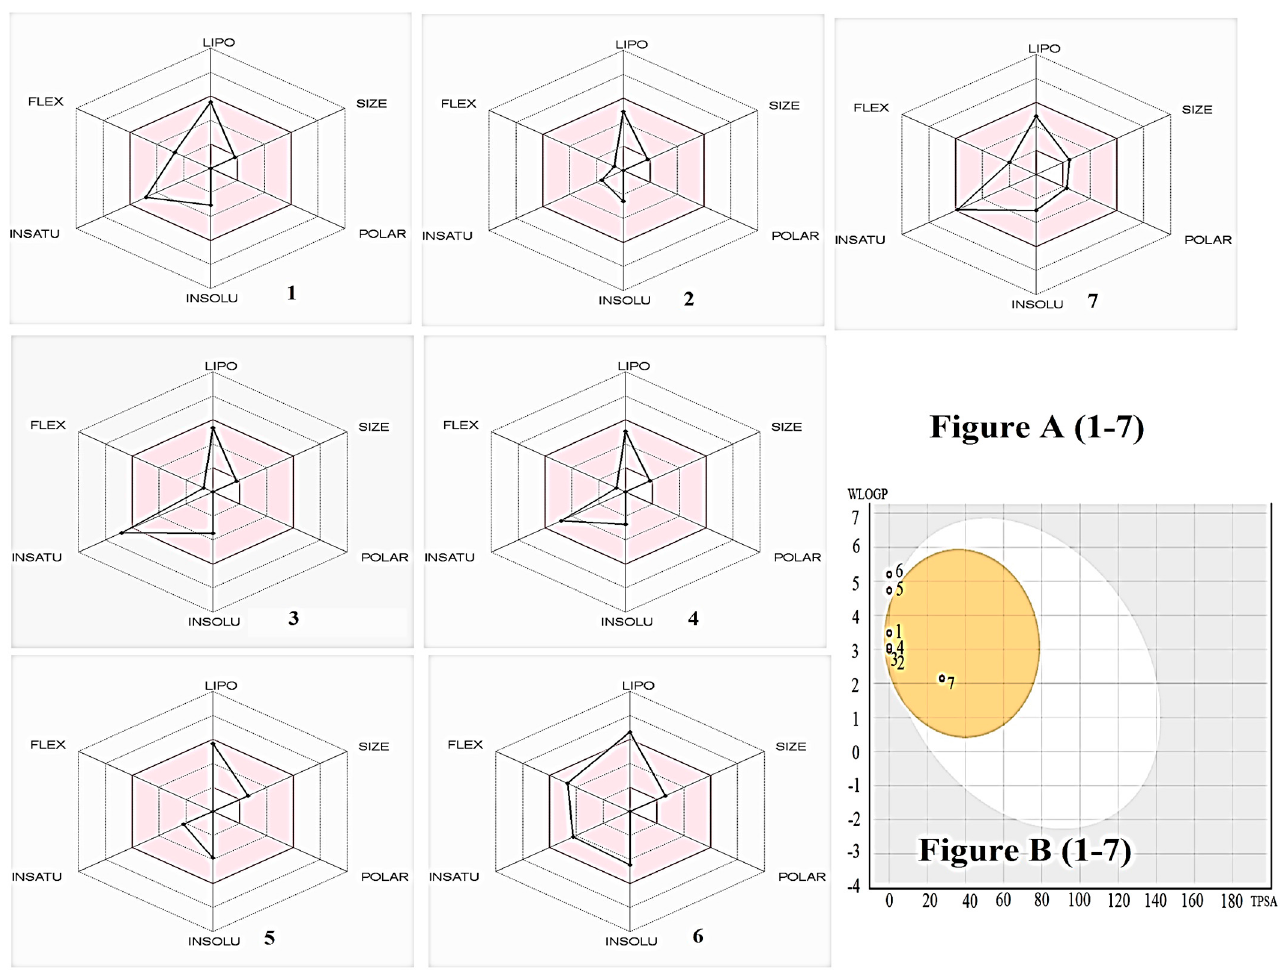
Figure 3. ( A ): bioavailability radar, ( B ): Predicted BOILED-Egg diagram of β -Myrcene ( 1 ), Sabinene ( 2 ), Benzene, (2-methyl-1-propenyl) ( 3 ), p -Mentha-1,5,8-triene ( 4 ), β -Caryophyllene ( 5 ), β -Farnesene ( 6 ), Myristicin ( 7 ) and using Swiss ADME software. Table 4. In silico PASS and ADME Prediction of PCEO major metabolites.